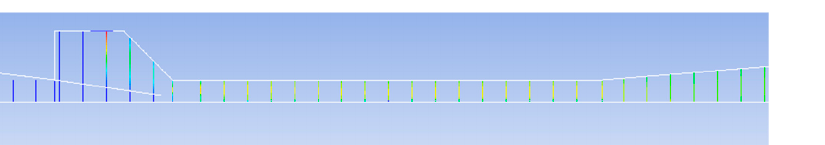
Figure 15. Ejector segmentation to calculate the average mass fraction in each part.